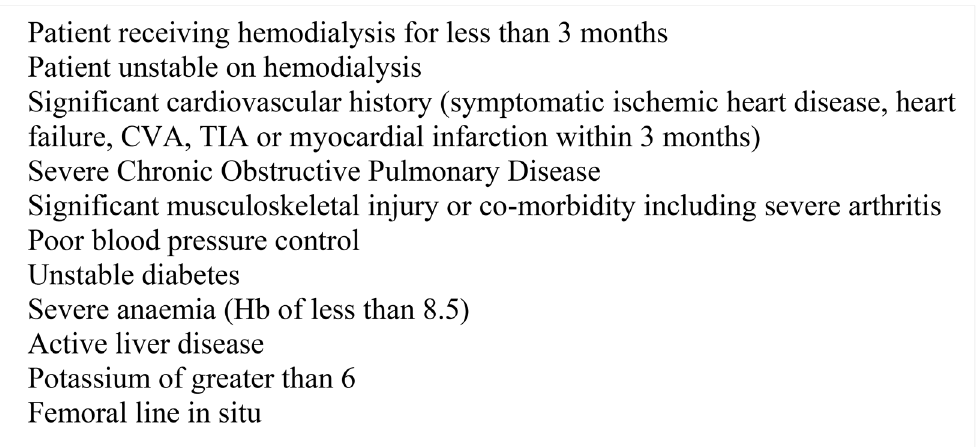
Fig 1. Exercise eligibility criteria. The inclusion criteria applied to the patient participants. It was deemed unreasonable to gather views regarding an exercise programme from patients who were not fit to participate in such a